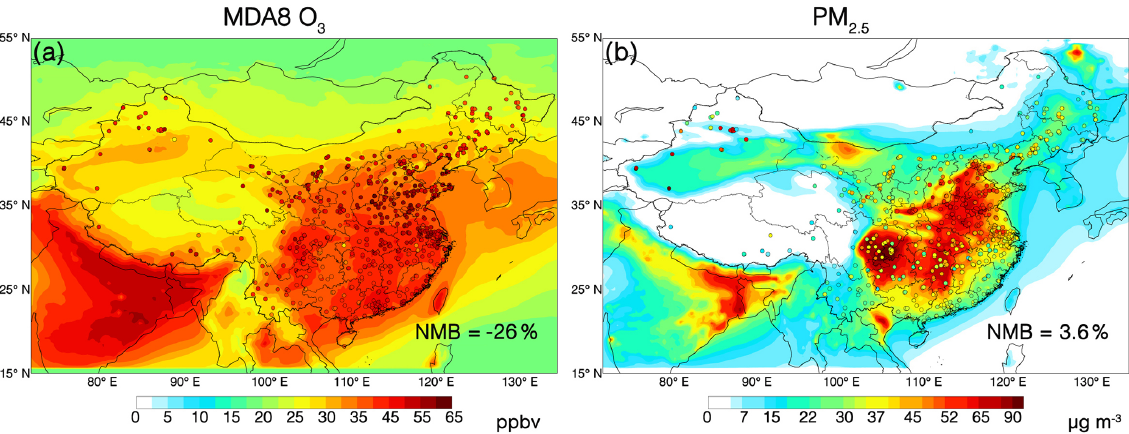
Figure 4. Annual mean surface concentrations of (a) MDA8 O 3 and (b) PM 2 . 5 over China in 2018. GEOS-Chem model values from the Base case are shown as contours. Observations from the China National Environmental Monitoring Center (CNEMC) are shown as